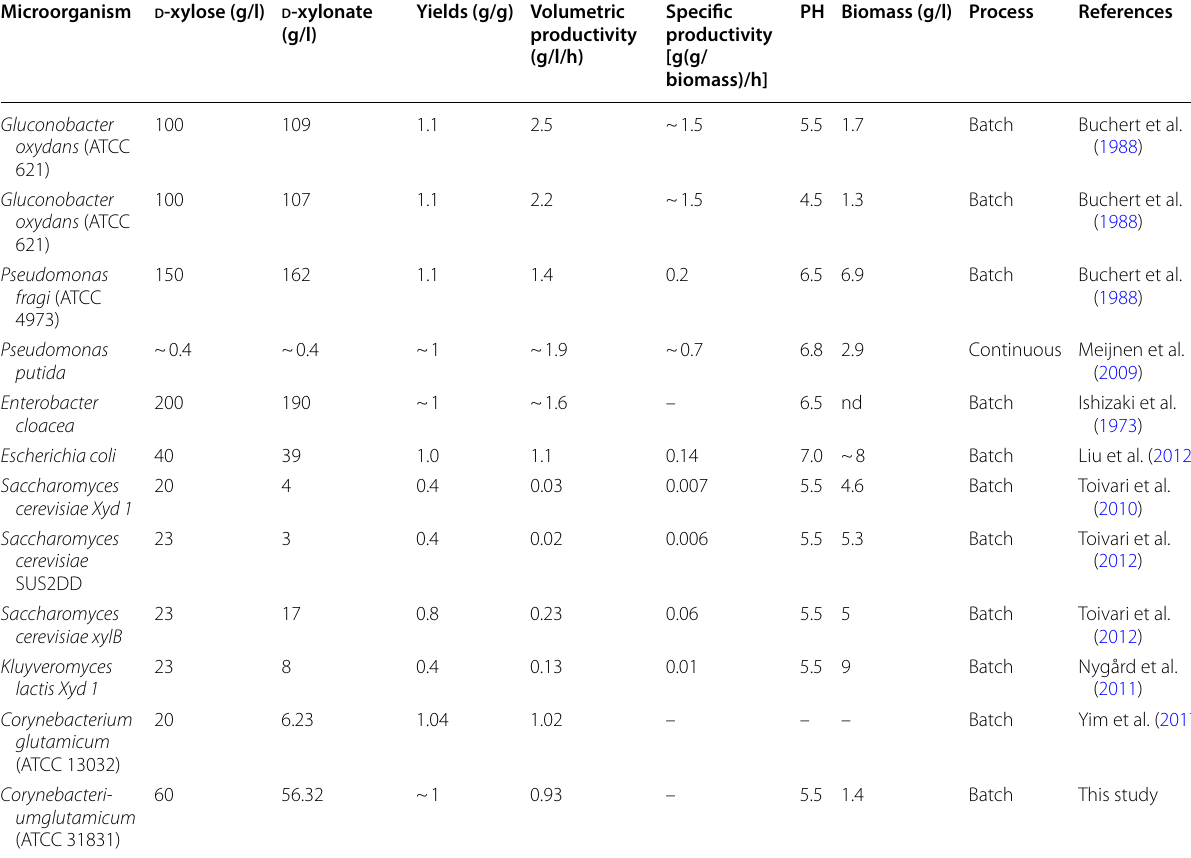
Table 4 Comparison of xylonic acid production and productivity by the best xylonic acid producers Microorganism d -xylose (g/l) d -xylonate